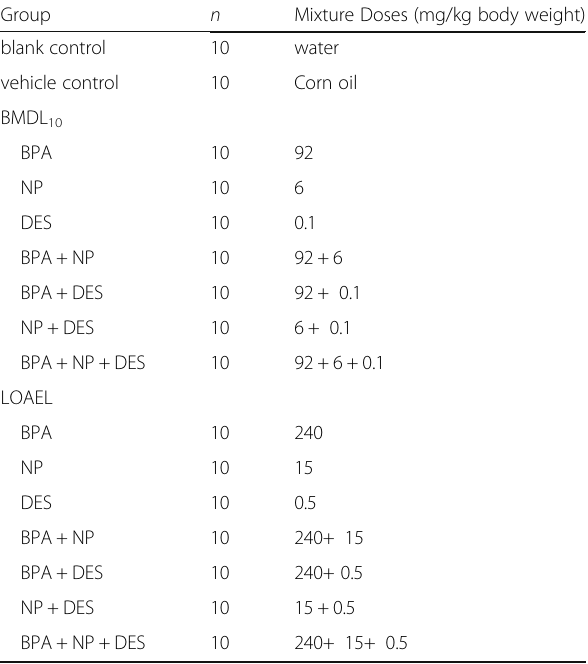
Mixture design Table 1 Dose combination of DES, BAP and NP